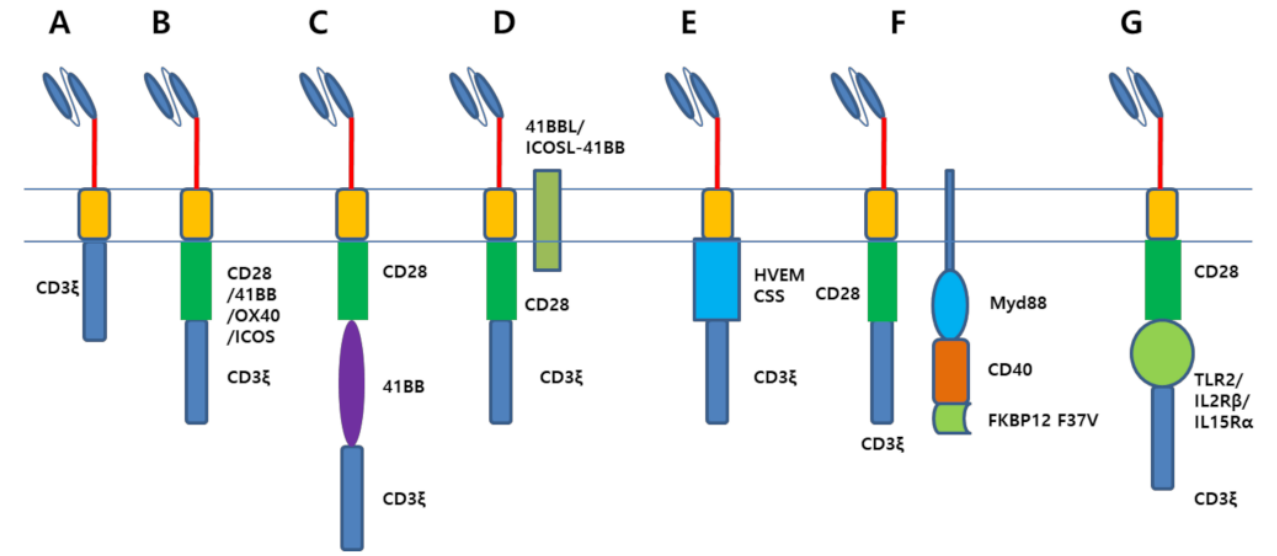
Figure 1. Various constructs of chimeric antigen receptor. ( A ). First-generation CAR construct is composed of a single chain variable fragment fused with a CD3 ζ endodomain. ( B ). Second-generation CAR construct has a costimulatory domain including CD28, 4-1BB, OX40, or ICOS. ( C ). Third-generation CAR construct has two costimulatory domains. ( D ). Coexpression of ligand of immune activating receptors, such as 41BBL or ICOSL-41BB, enhanced the anti-tumor effect of CAR T cell. ( E ). Recent report demonstrated that herpes virus entry mediator (HVEM) co-stimulatory signal domain (CSS) can be used for CAR constructs. ( F ). Myd88/CD40 signaling greatly potentiated the CAR activity in preclinical models. Myd88/CD40 signaling can be modulated by dimerization of FKBP12 F37V domain. ( G ). Toll-like receptor (TLR) domain and cytokine receptor domains (IL2R β or IL15R α ) were used as co-stimulatory domain to increase CAR T cell